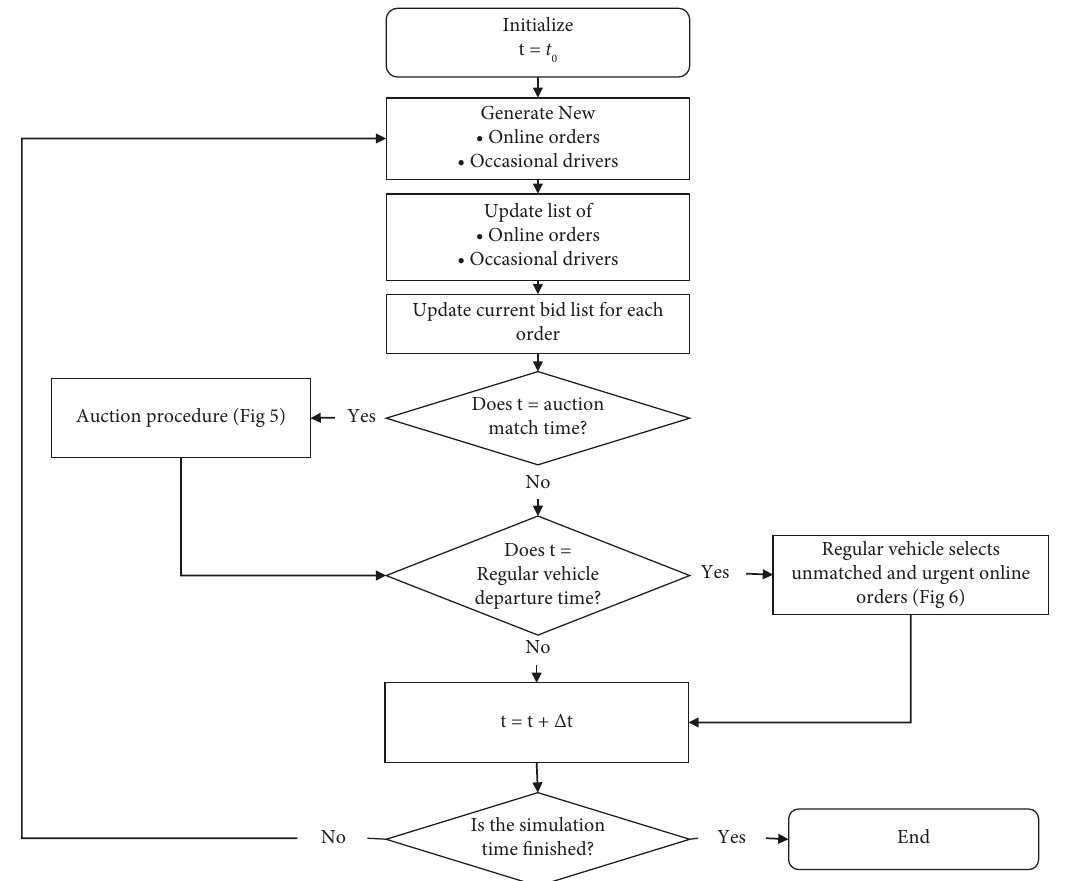
Figure 4: Flowchart of the simulation procedure.